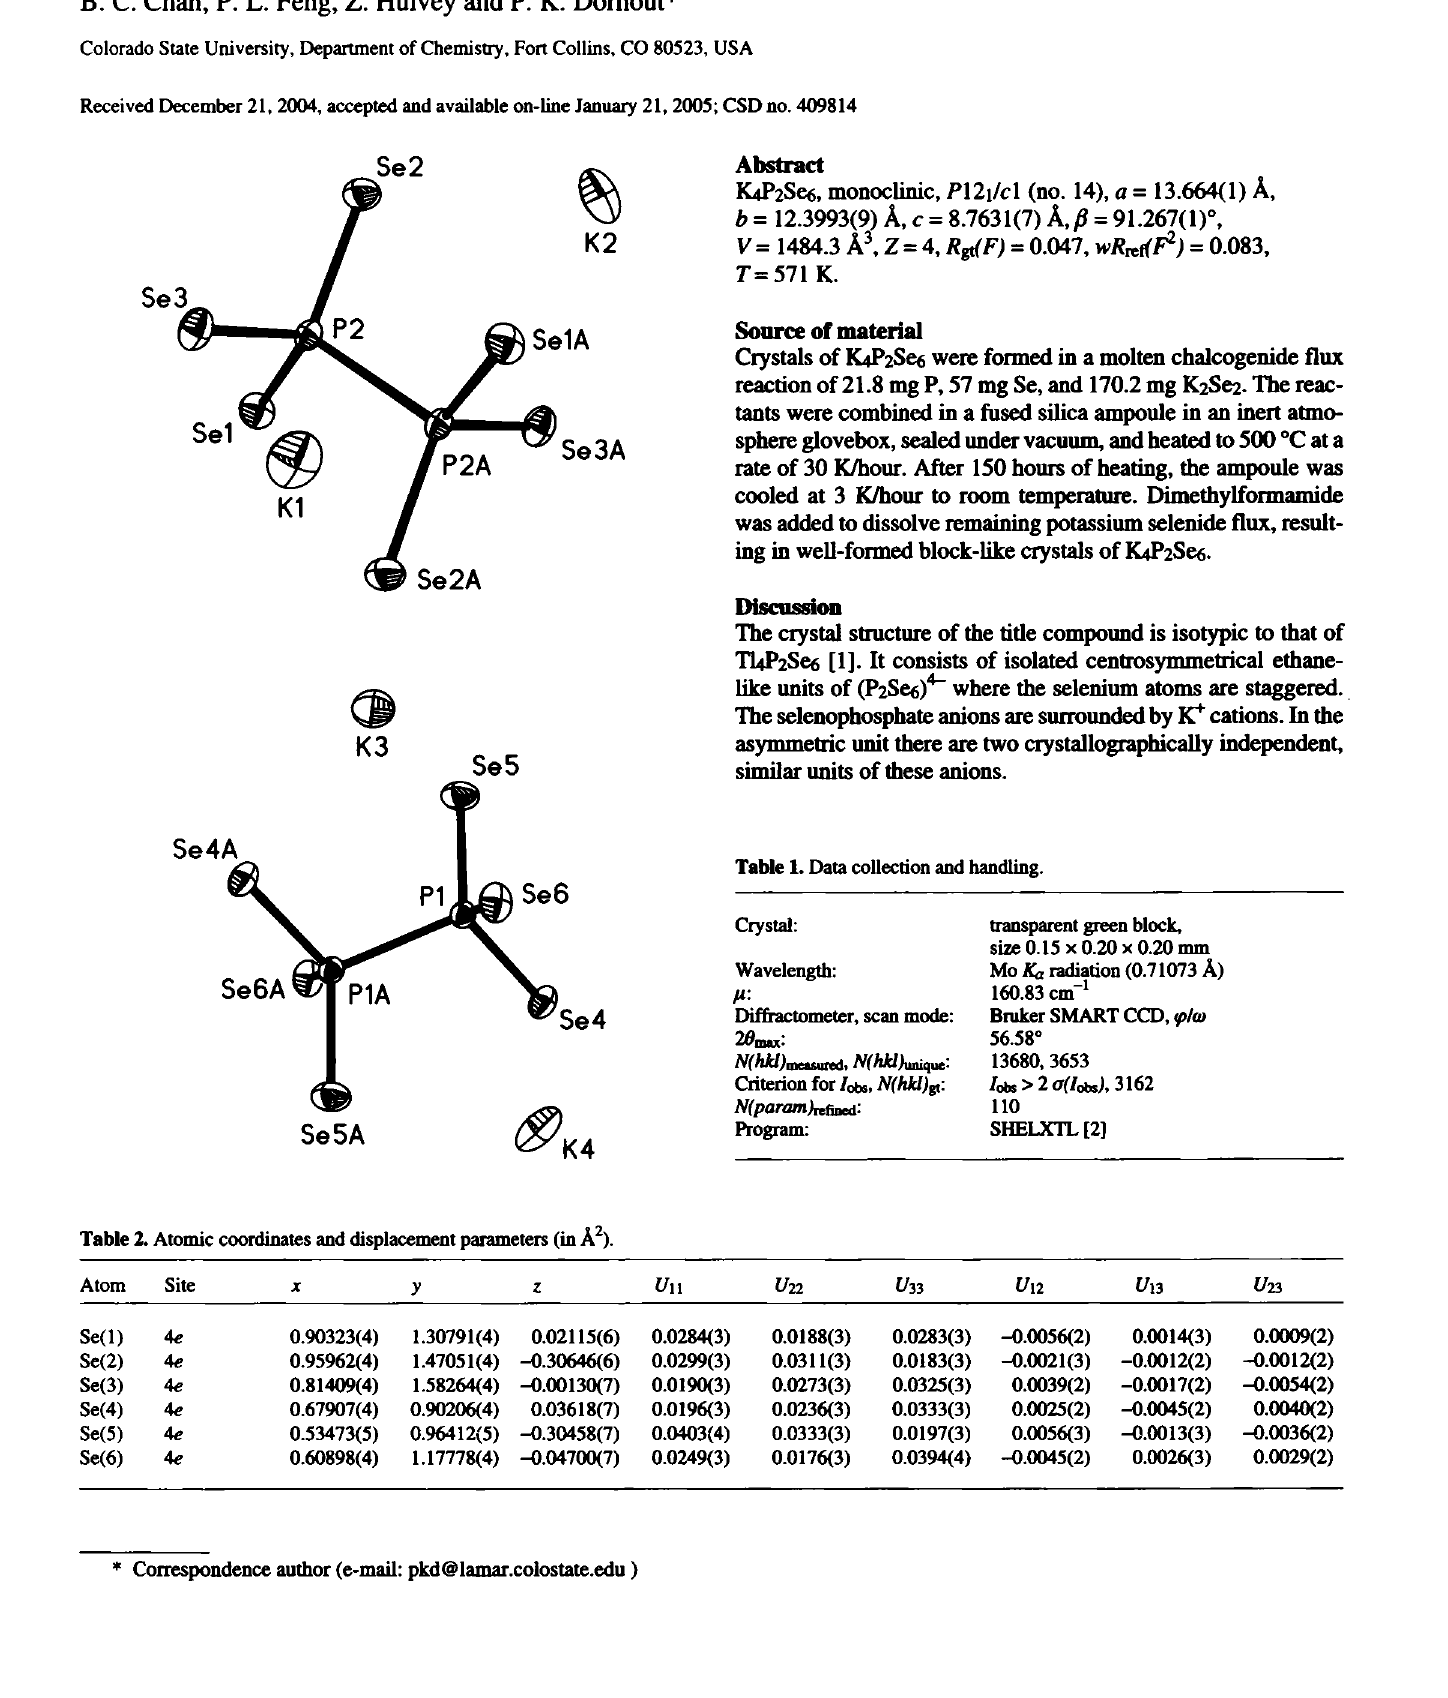
Table 2. Atomic coordinates and displacement parameters (in Ä 2